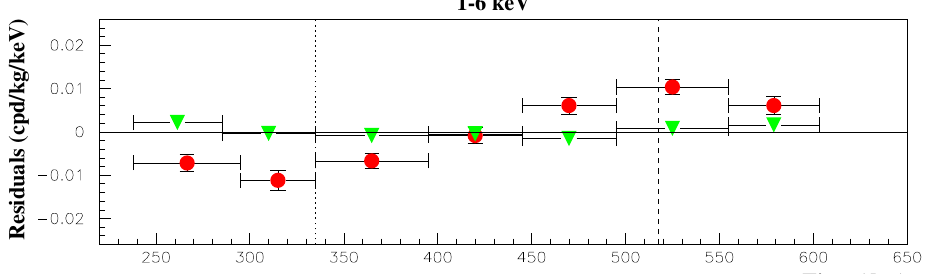
Figure 3. Residual rates of single-hit events (circles), class of events to which DM events belong, and of multiple-hit events (filled triangles), class of events to which DM events do not belong. The DAMA/LIBRA–phase2 is considered; the data points are reported as collected in a single annual cycle and have been obtained through the same hardware and software procedures. The time scale is the same as the previous DAMA papers for consistency [4–6,24,32]. The experimental points present the errors as vertical bars and the widths of the associated time bins as horizontal bars. Reprinted